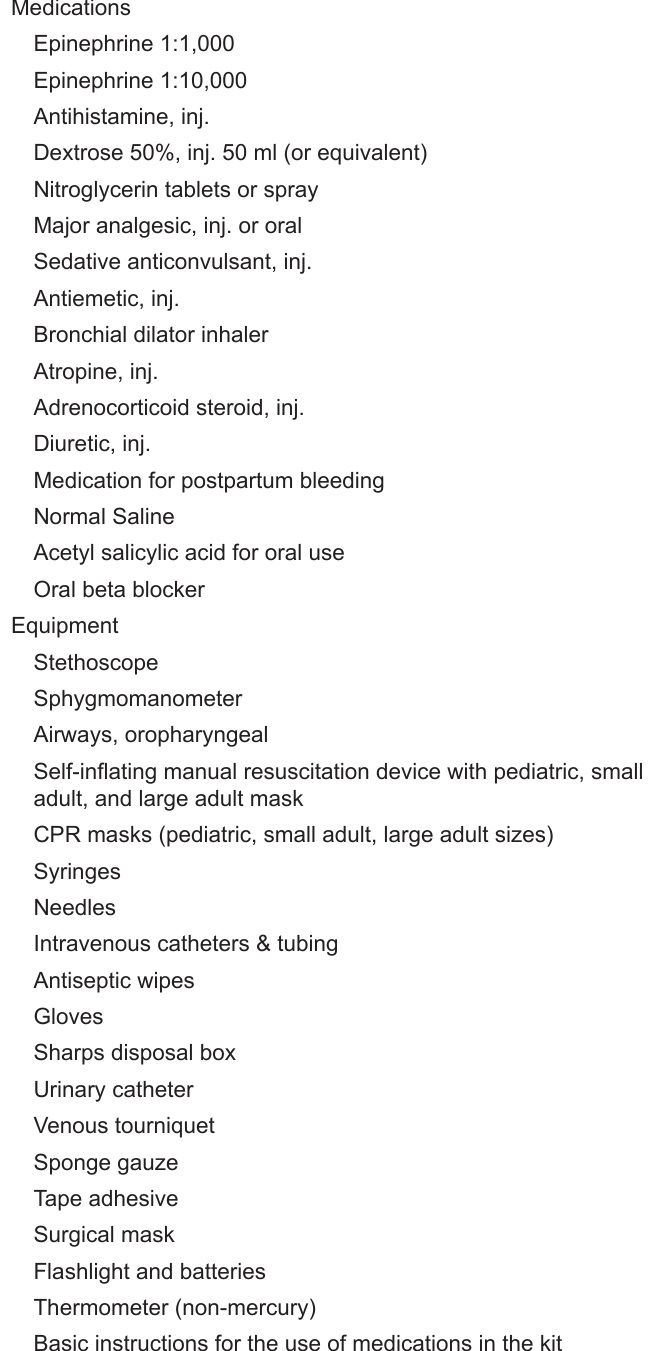
Table 4. General approach to managing in-flight medical incidents.